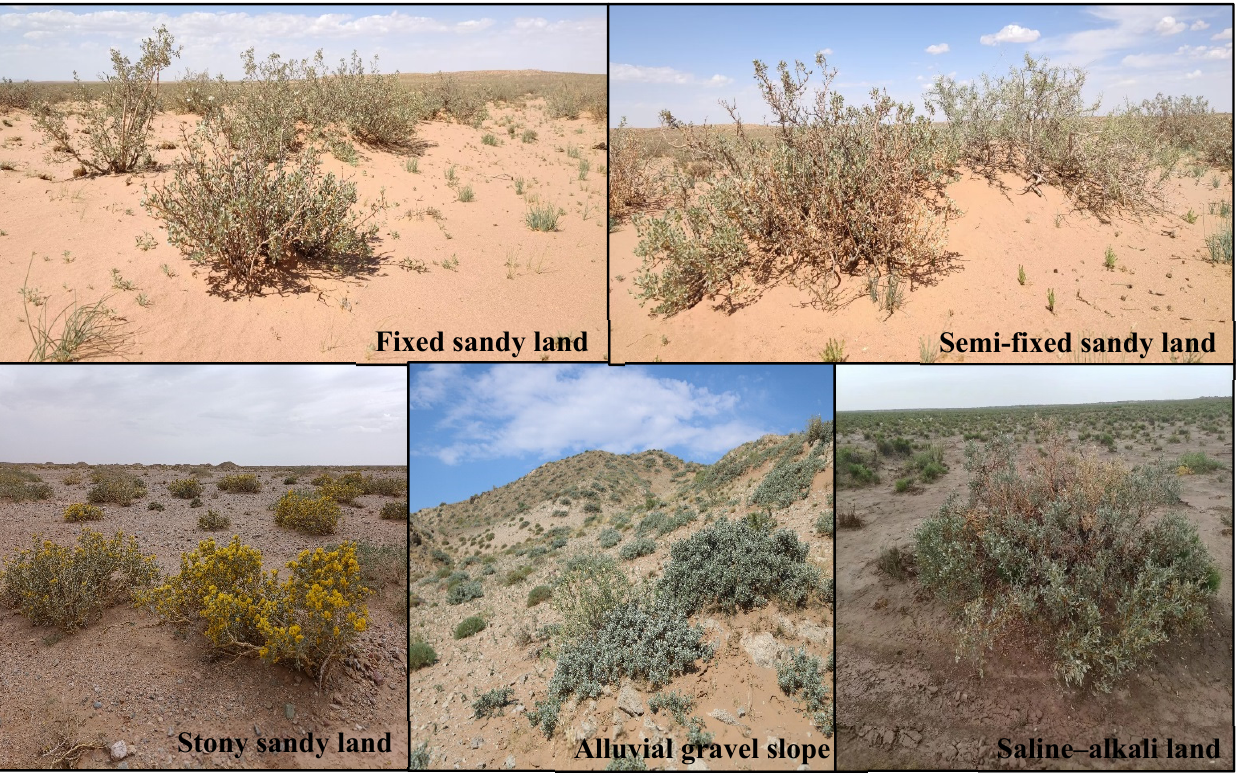
Figure 4. Five habitat types of A. mongolicus.